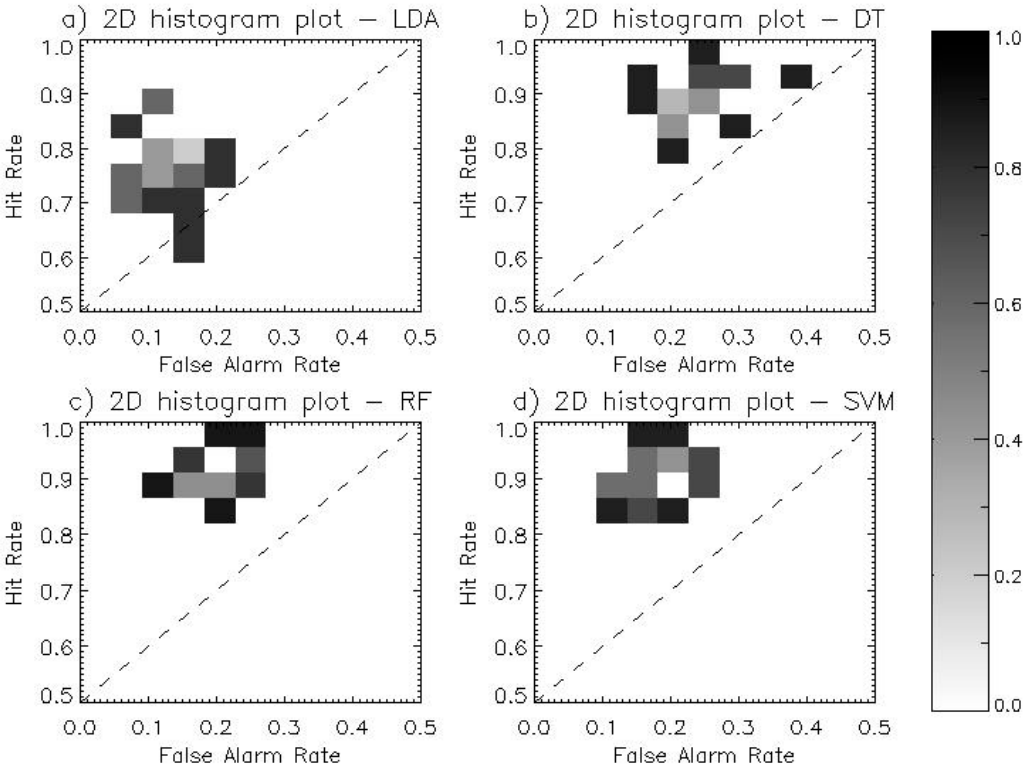
Figure 9. Two-dimensional normalized histogram plot for ( a ) LDA, ( b ) DT, ( c ) RF, and ( d ) SVM of different validation tests. The x-axis represents a false alarm rate versus y-axis represents a hit rate from 2 × 2 contingency table of observed and model-forecasted DEVs and non-DEVs.